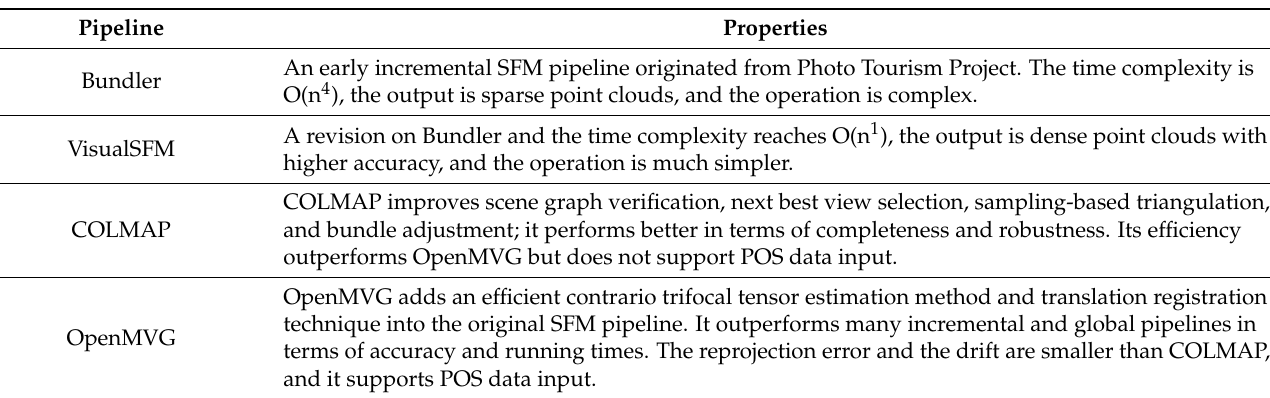
Table 1. Popular SFM Pipelines